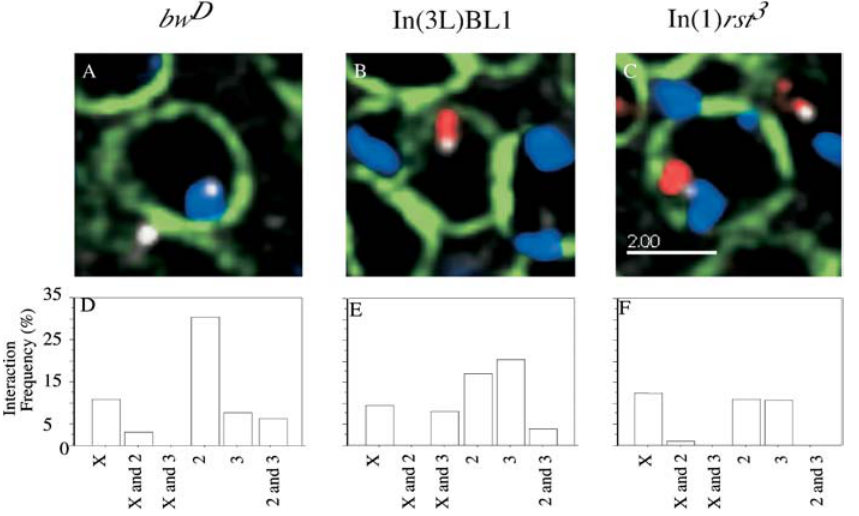
Figure 7. Interaction of Variegating Genes with Heterochromatin on Other Chromosomes All three lines were examined to see how often variegating genes interacted with heterochromatin on their own and other chromosomes. (A) Close-up of In(1) rst 3 nucleus showing variegating gene interaction with heterochromatin on its own chromosome. (B) Close-up of In(1) rst 3 nucleus showing variegating gene interaction with heterochromatin on a different chromosome. (C) In(1) rst 3 nucleus showing variegating gene interaction with heterochromatin on both its own and another chromosome. (D–F) Bar plots of interaction frequencies of variegating genes with their own heterochromatin and that found on other chromosomes. A distance of 1.0 l m was chosen as the maximum distance for interaction to occur. DOI: